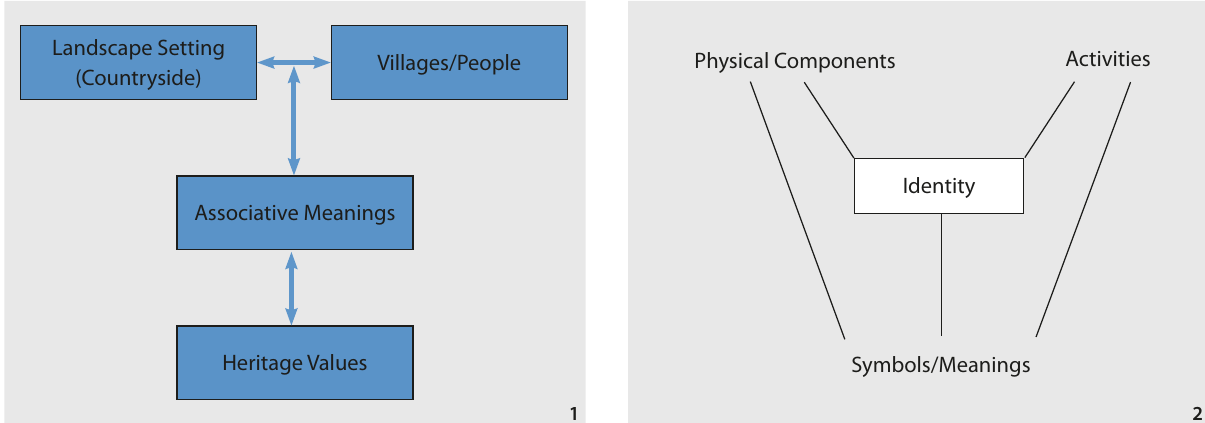
Figure 1 Contextual theme: inseparable link between landscape setting (countryside), villages and people (Source: the author). Figure 2 Place identity and its components (Source: Relph